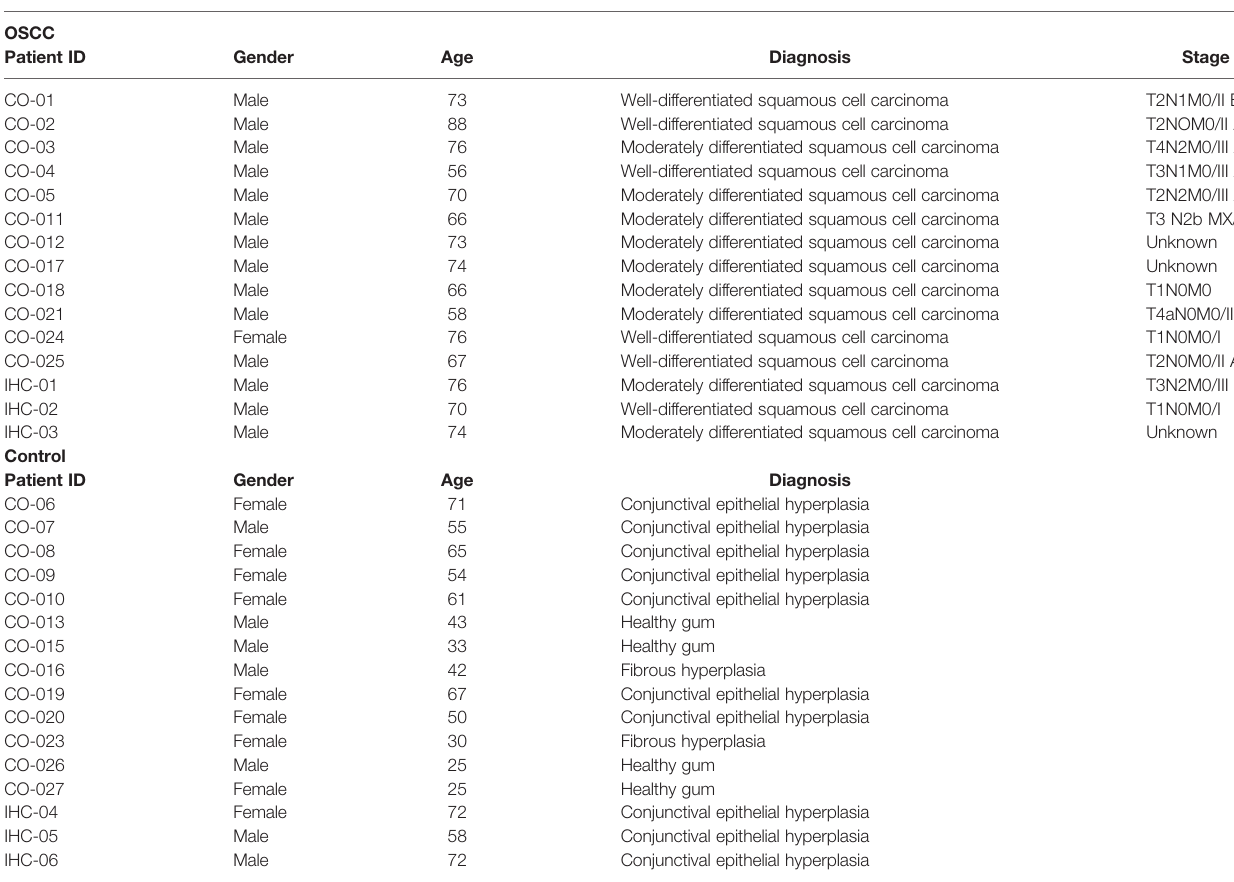
TABLE 1 | Patient